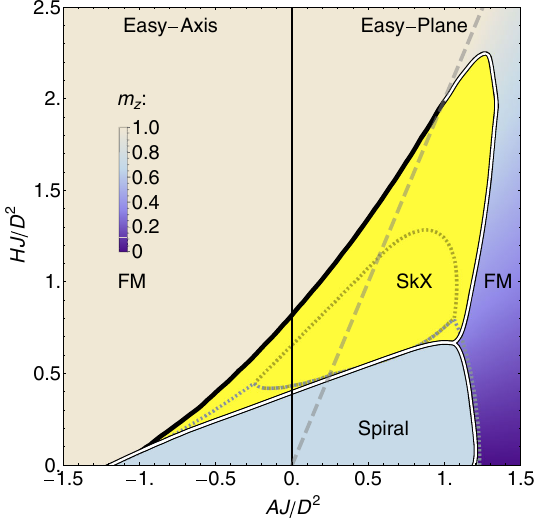
FIG. 3. T ¼ 0 anisotropy-field phase diagram from a linear ansatz and 2D square-cell calculation . The phase diagram shown here is obtained as a result of a full 2D variational calculation, distinct from the effectively 1D variational calculation shown in Fig. 1(b). The symbols and parameters used are exactly the same